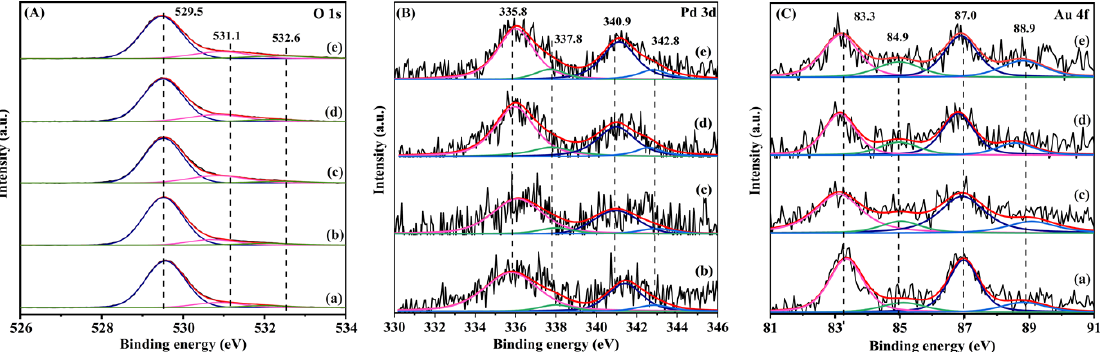
Figure 3. ( A ) O 1s, ( B ) Pd 3d, and ( C ) Au 4f XPS spectra of ( a ) 0.36AuTiO 2 , ( b ) 0.33Pd/TiO 2 , ( c ) 0.35AuPd 0.46 /TiO 2 , ( d ) 0.34AuPd 2.09 /TiO 2 , and ( e ) 0.37AuPd 2.72 /TiO 2 .